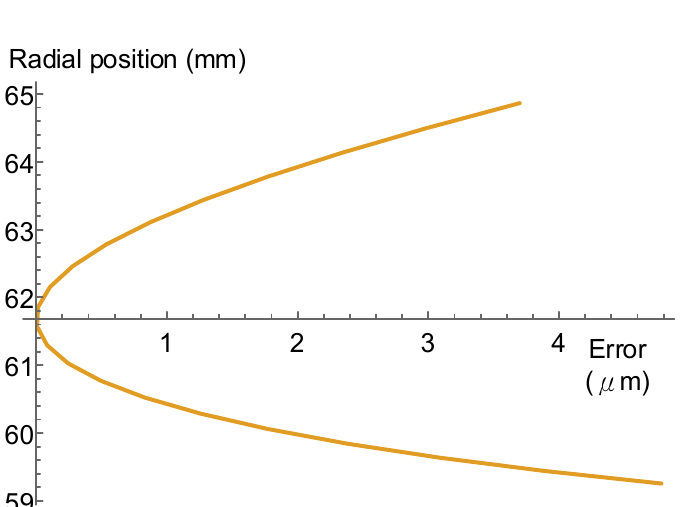
Figure 10. Cutter edge profile error of the original case of the cutter face, with 0